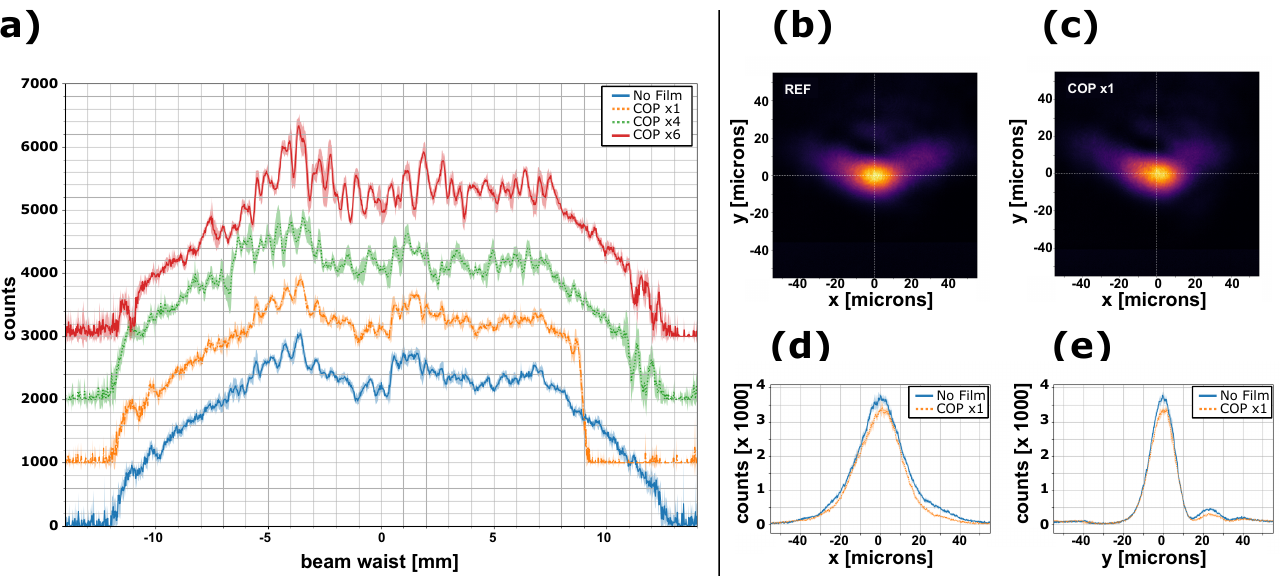
Figure 4. Beam profile with COP film. In ( a ) central line outs from near field images are compared with increasing number of film passes from bottom to top: reference beam (no film); a single 0.1 mm film (showing hard cut in beam due to mounting); 4 × 0.1 mm; and 6 × 0.1 mm, respectively. The input energy is kept at 160 mJ. In ( b ) the REF focus is shown without a film in place while ( c ) shows the focus after the 1 × COP [0.1 mm] film is placed in the beam. In ( d ), the comparison with/ without the film in place of the horizontal line out is shown while ( e ) compares the same along the vertical